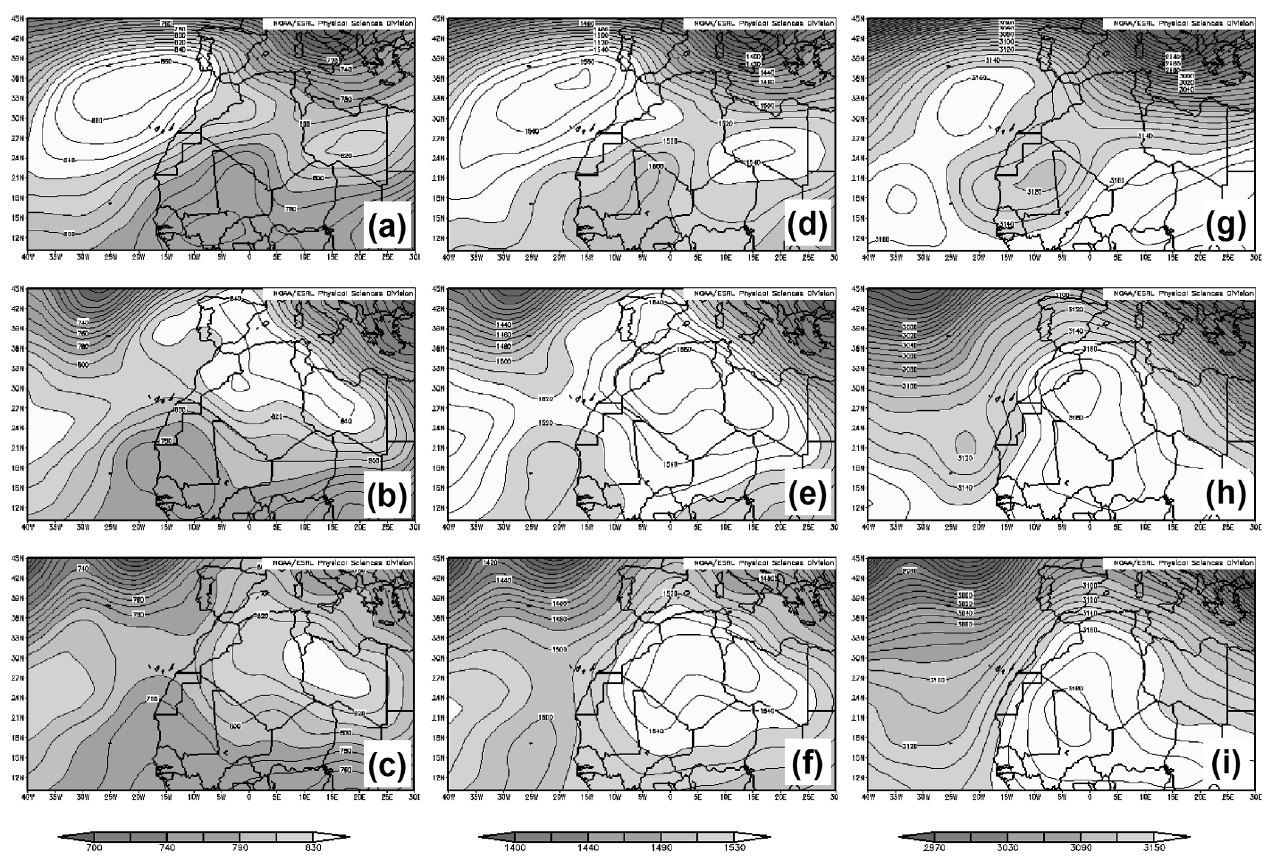
Fig. 2. Meteorological synoptic charts at three geopotential heights: 950hPa (800m a.s.l., a – c ), 850hPa (1500m a.s.l., d – f ) and 700hPa (around 3000m a.s.l., g – i ). Figure panels correspond to three different dates as representative of both non-dusty and dusty conditions depending on each station (from top to bottom panels): 11, 13 and 14 March